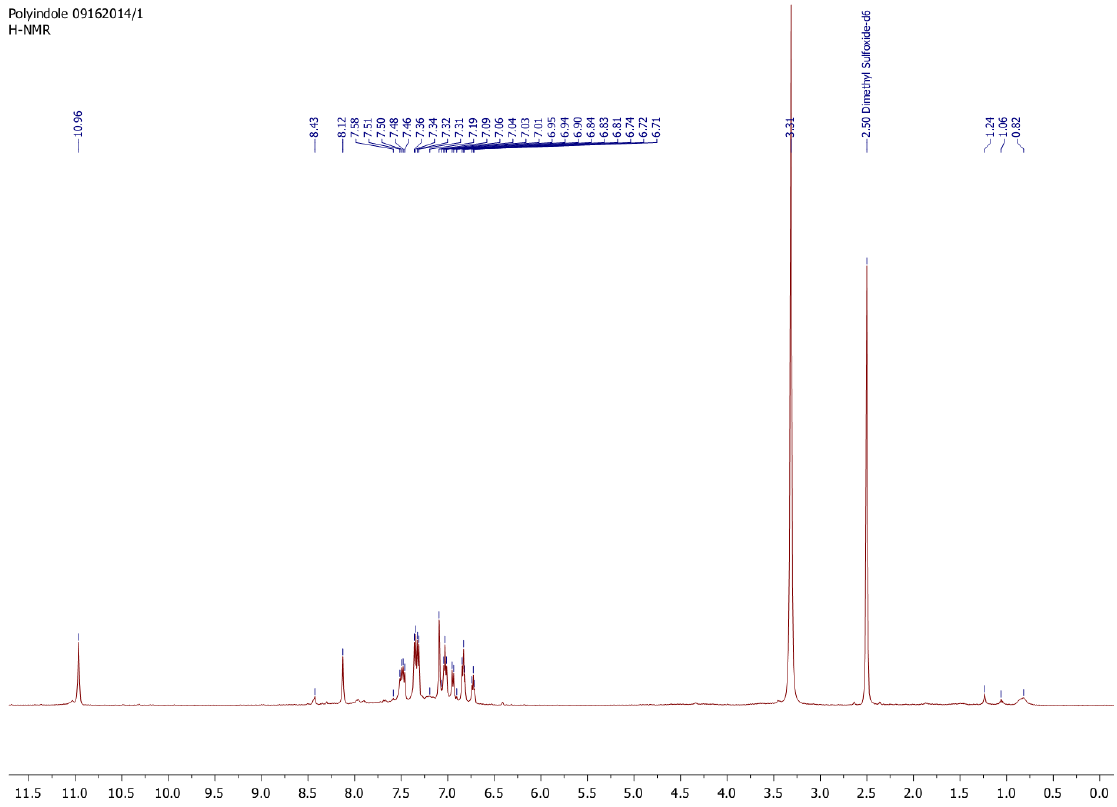
Figure A3. 1 H-NMR of SBP catalyzed polymerization product of indole in deionized water and